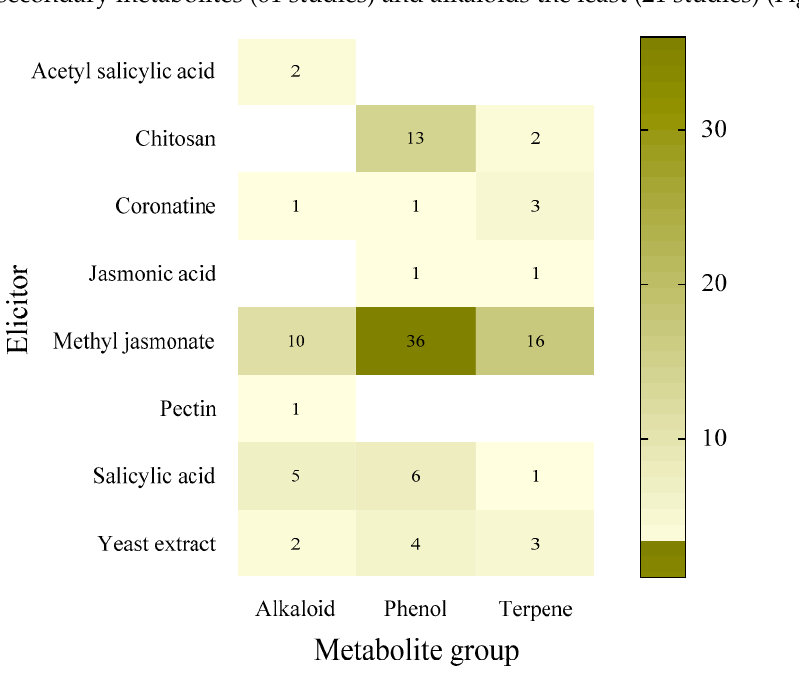
Figure 1. Number of recorded uses of each elicitor in hairy roots by group of secondary metabolites from 2010 to 11 January 2022.